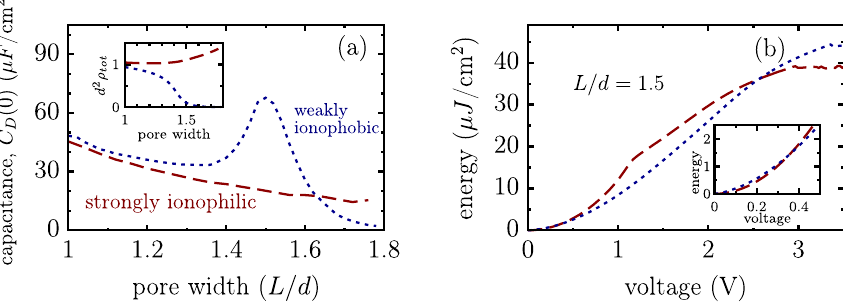
ð 0 Þ , as a function of pore width and (b) the stored energy as a function of voltage D T ) and strongly ionophilic ( δ E ¼ 10 k T ) B B